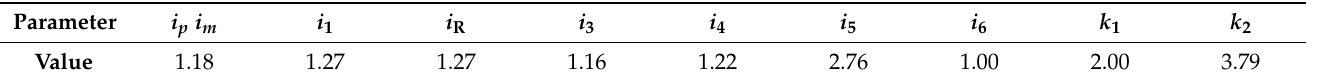
Table 1. Design values of transmission system